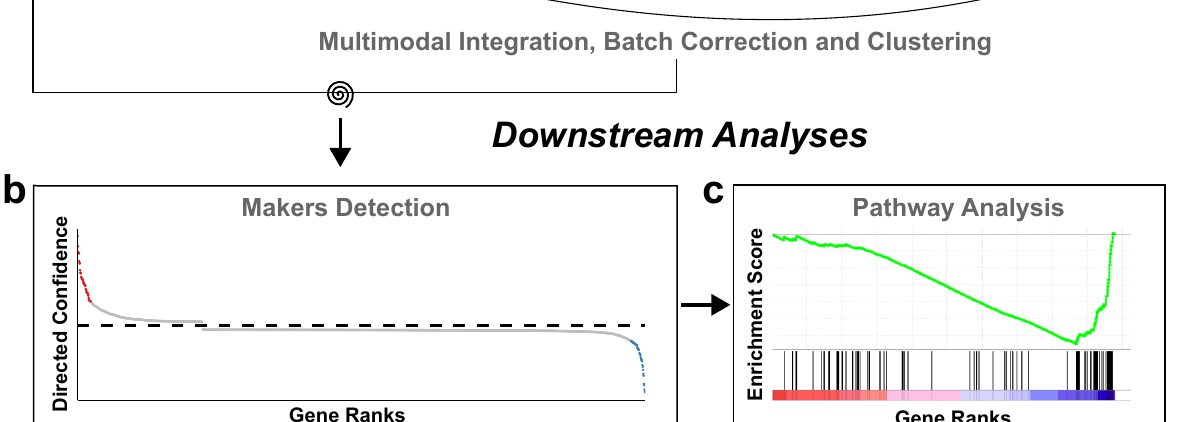
(with latent feature dimension, z ). This is designed for batch effect correction. scMDClearns a latent representation Z (in dimension z ) of data on which different modalities are integrated. A deep K-means algorithm and a KLD loss are imple- mented on Z . Based on the clustering results, scMDC employs an ACE model 36 to detect markers in different clusters ( b ). Then, pathway analyses can be conducted based on the gene ranks learned by ACE ( c